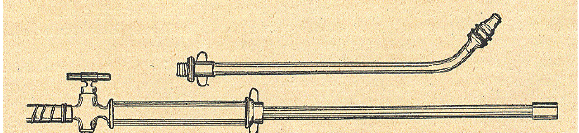
Figure 11. Devices to produce the Bordeaux mixture (drawing from Müller,